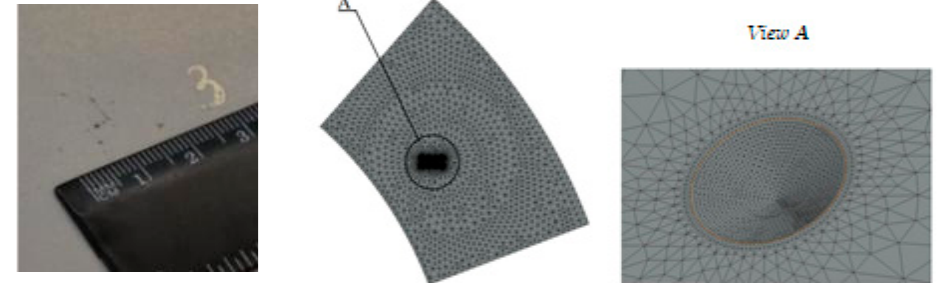
Figure 14. Actual defect and calculation grid for a defect on a disc segment.